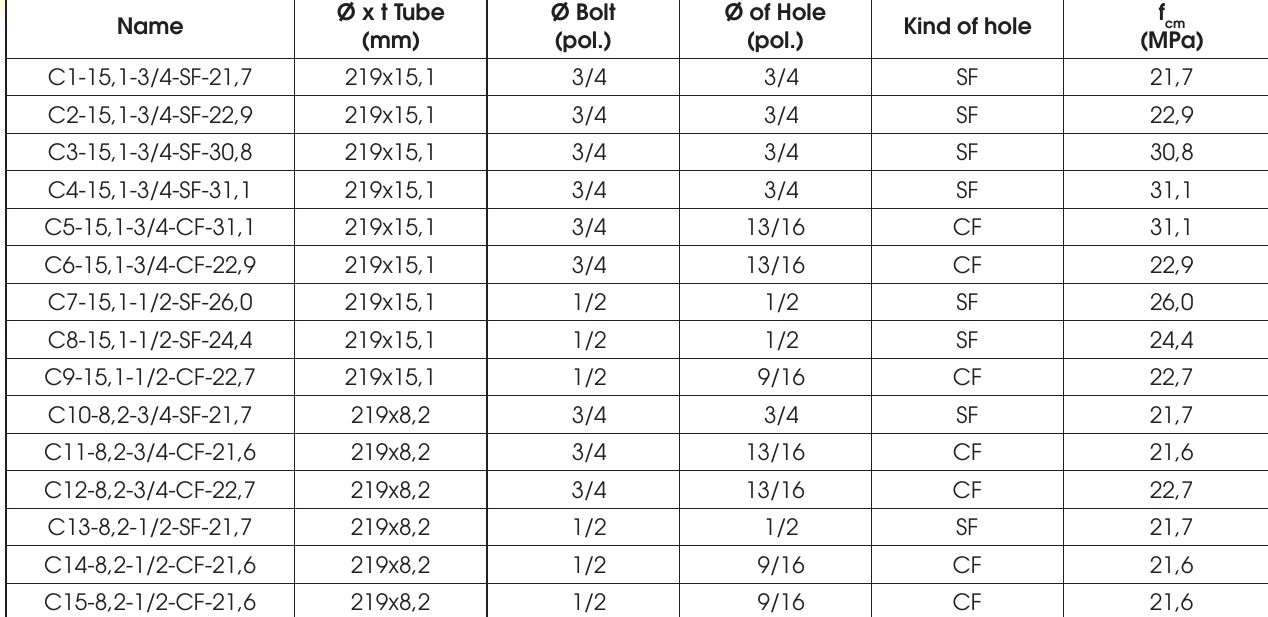
Experimental analysis of a mechanical shear connector in concrete filled steel tube